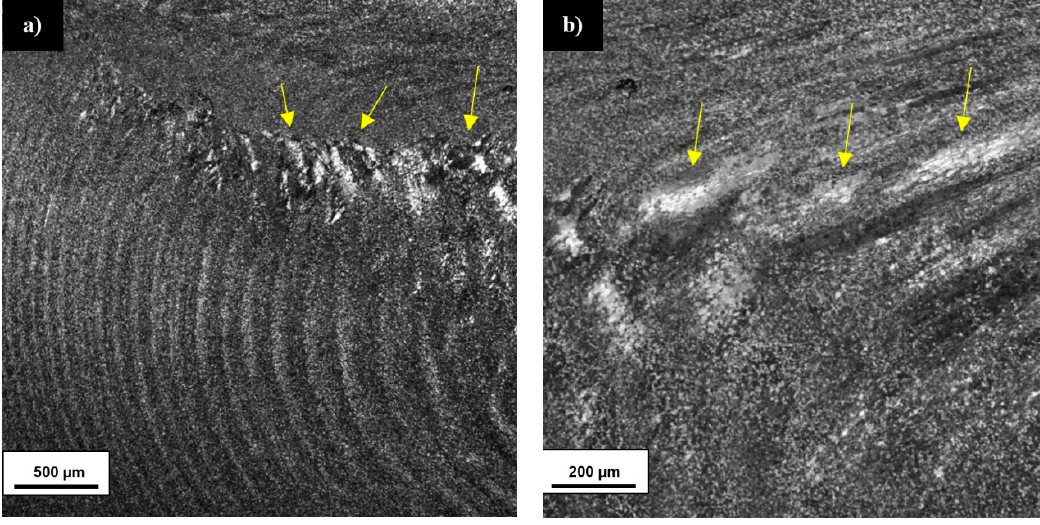
Figure 5. Light microscopy image of the stir zone with the distinctive areas in the ( a ) A41 sample and ( b ) A81 sample.